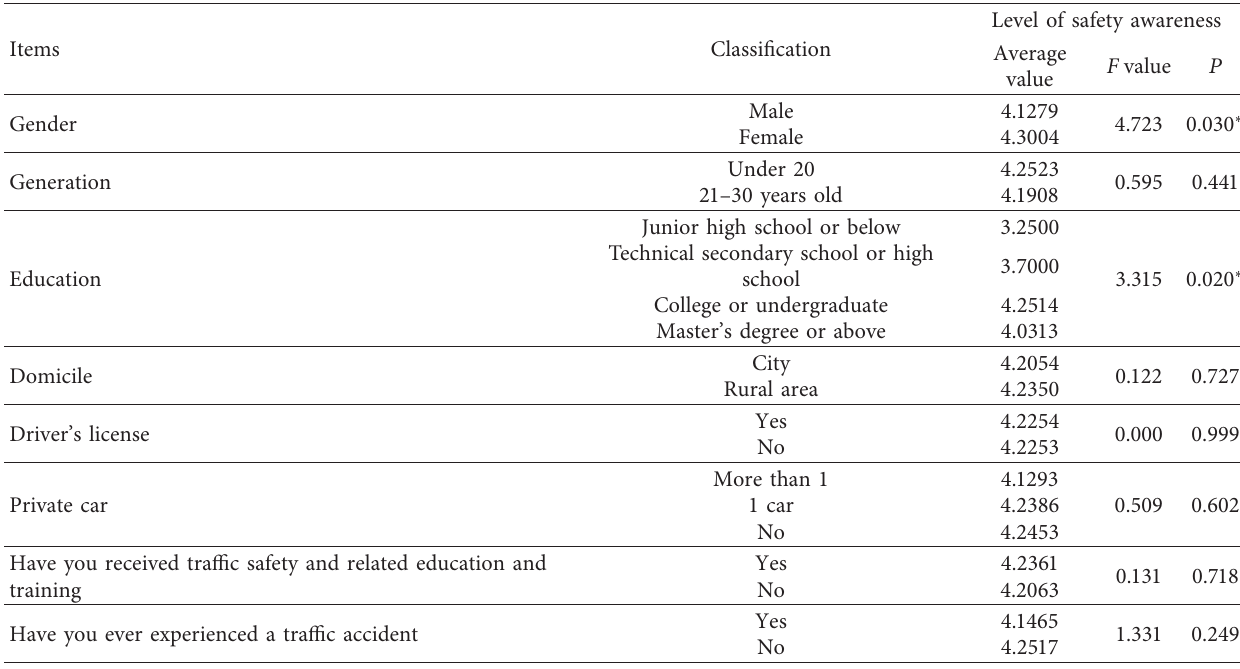
Table 5: Analysis of variance for safety awareness among young pedestrians ( N �